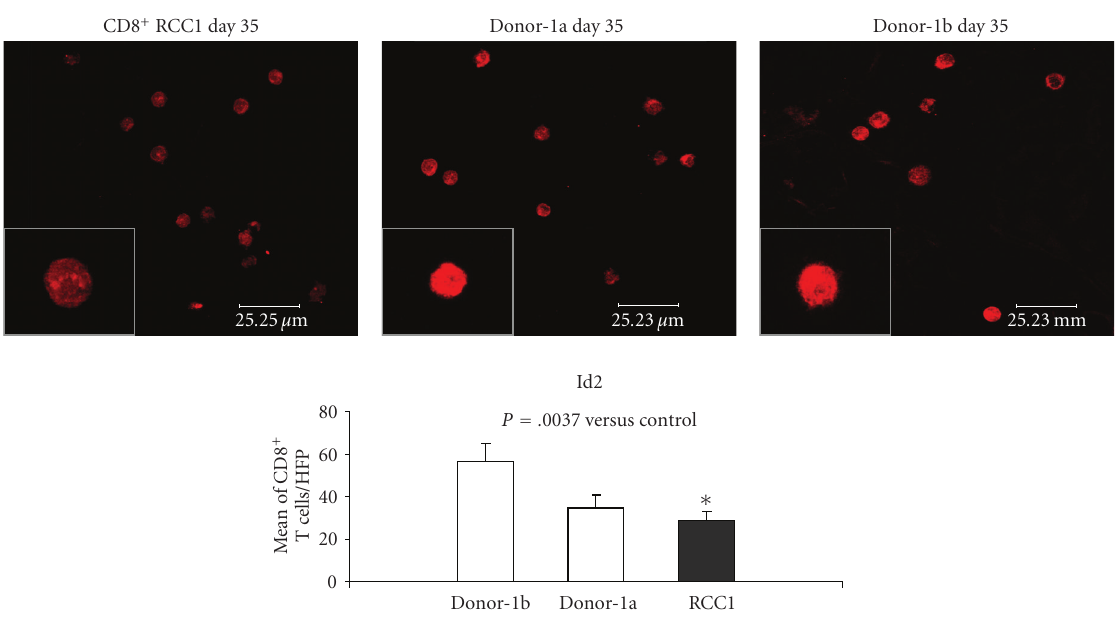
Figure 9: Altered expression of Id2 in RCC patient CD8 + T cells. CD8 + T cells were surface-labeled with anti-Id2 (red) mAb and the performance of confocal microscopy analysis. Quantitative analysis of HPF was carried out by confocal microscopy software (Leica, TCS- SP2; Student’s t -test, P < . 05). Data are from 1 of 5 experiments that all gave similar